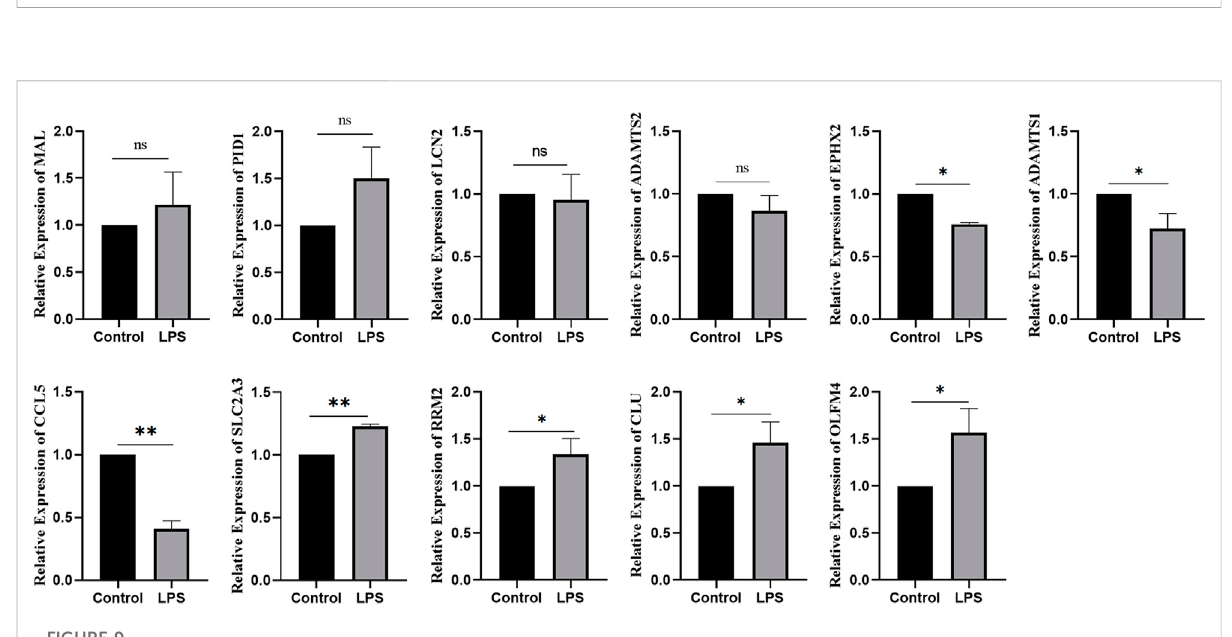
FIGURE 9 Expression of ferroptosis genes in LPS-induced SA-AKI.*: p < 0.05; **: p <